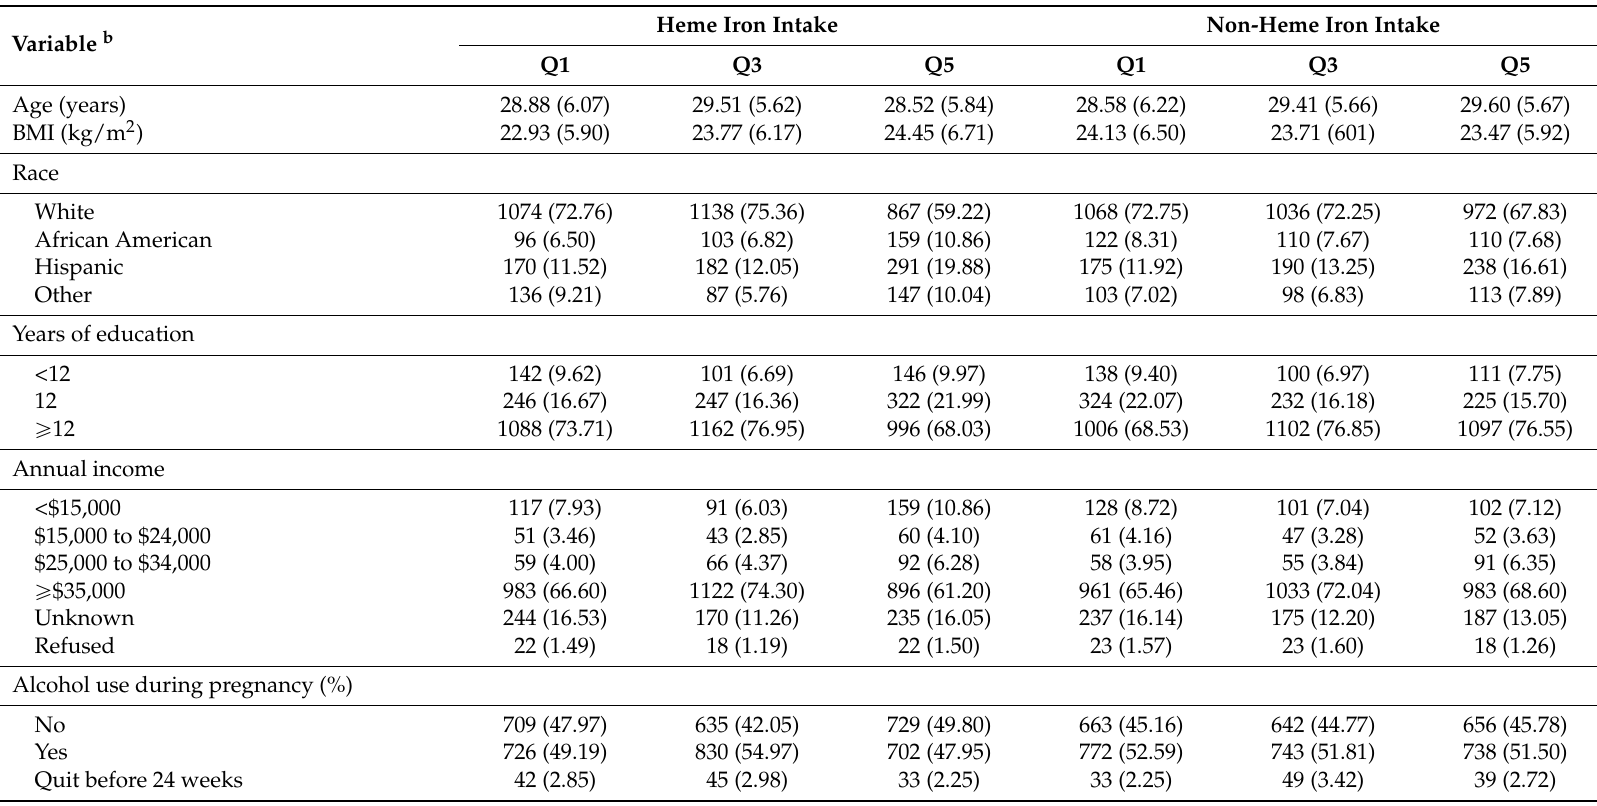
Table 1. Baseline characteristics by quintiles a 1, 3, and 5 of total preconceptional dietary iron intake ( n =